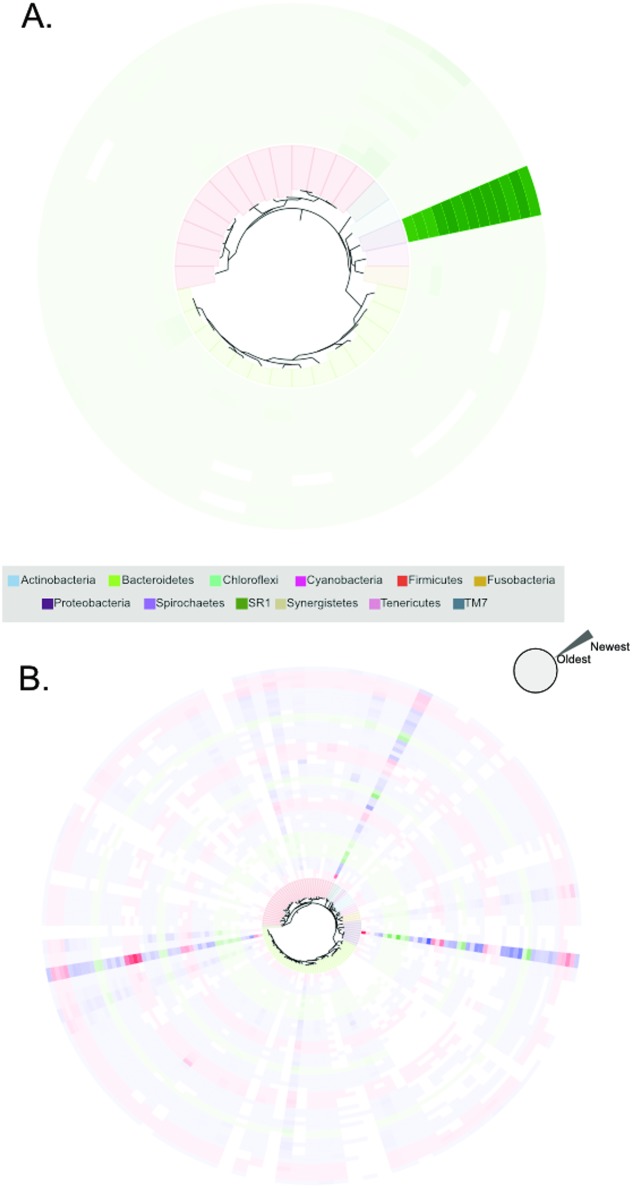
Examples of stability and variability in the CF lung microbial communities of two select participants (C and E).A. Visualization of the stability of participant C's lung microbial community over the study period. Each OTU is presented as a terminal node on the phylogeny; its presence in each sample evaluated using 16S rRNA gene sequencing is shown extending outwardly from the inner phylogeny in chronological order. The density of the color indicates the relative abundance of the OTU; when the OTU is not identified, the space is left blank. B. Participant E, who experienced 4 exacerbations over the course of the year, has a much more variable lung microbiota than participant C. Similar to Fig 5c, OTUs are represented as nodes in the phylogeny whose relative abundance is indicated with varying color density. Rings in the phylogeny are colored to indicate the sample type (Treatment red, Intermediate blue, Stable green). Density of the color indicates relative abundance of the OTU and time periods are colored according to the health state.